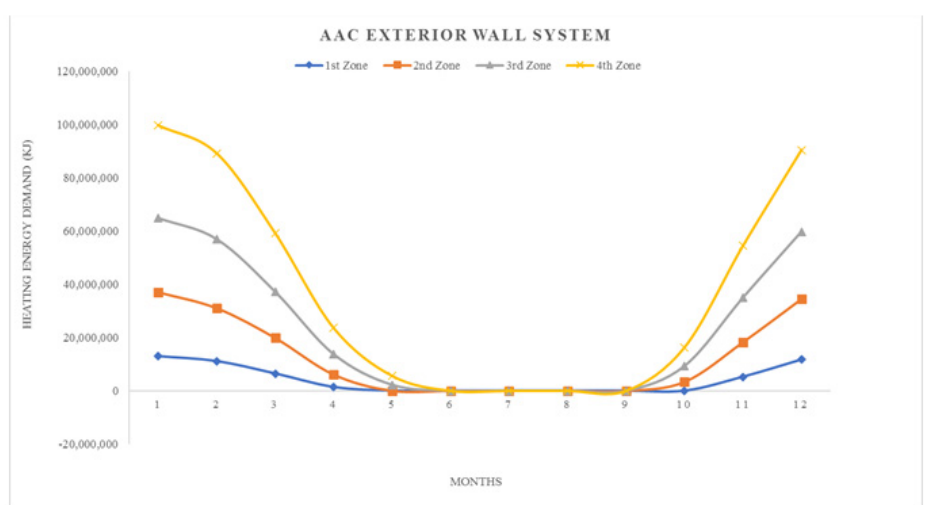
Figure 9. Heating energy demand for AAC exterior wall system .